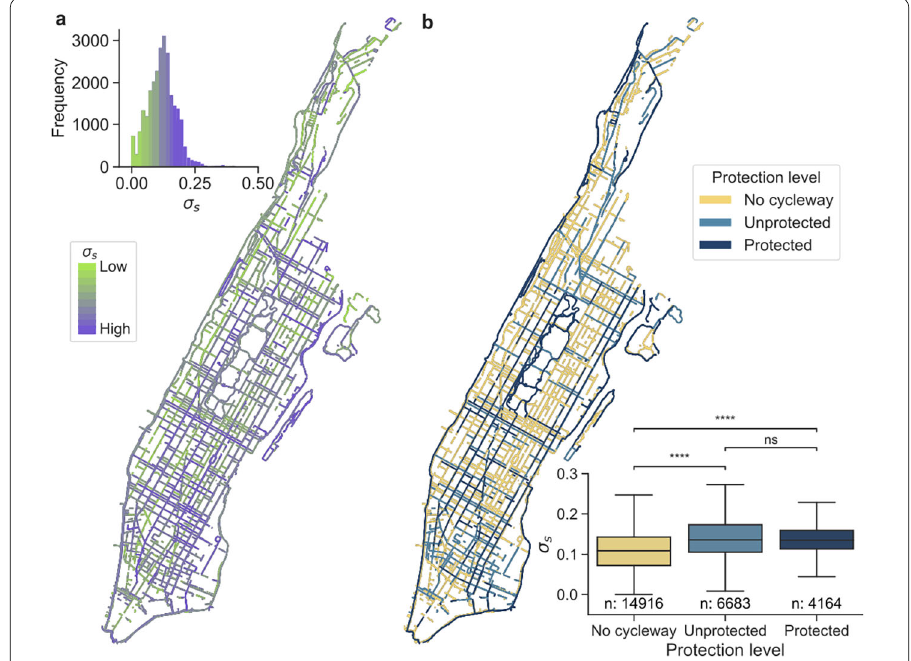
Figure 4 The case of New York City: streets characteristics and σ s . a ) The map displays streets in the borough of Manhattan included in the final sample. A 10-quantile color scheme has been used for the value of σ s . The inset is the distribution of σ s for streets included in the final sample (computed over the entire city of New York). b ) The map displays the protection level of streets in the borough of Manhattan included in our sample. Yellow: no cycleway, light-blue: unprotected cycleway, dark blue: protected cycleway. The inset displays the box plots of σ s for streets with different levels of protection (computed over the entire city of New York). ‘ns’, ‘*’, ‘**’, ‘***’, ‘****’ indicate the significance level of a Mann-Whitney-Wilcoxon test two-sided with Bonferroni correction, with the following p-values thresholds: 1e–4:‘****’, 1e–3: ‘***’, 1e–2: ‘**’, 0.05: ‘*’, 1: